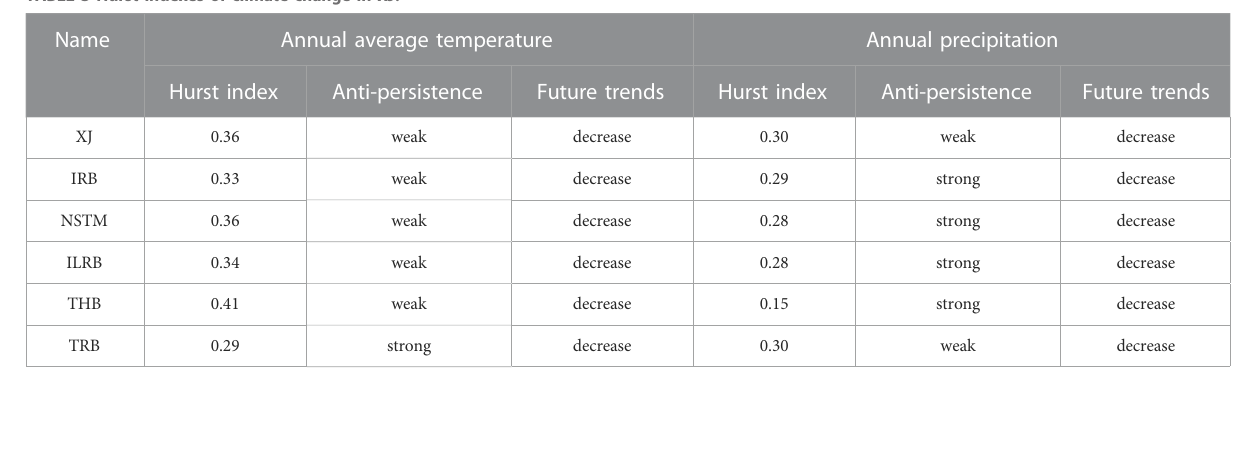
TABLE 3 Hurst indexes of climate change in